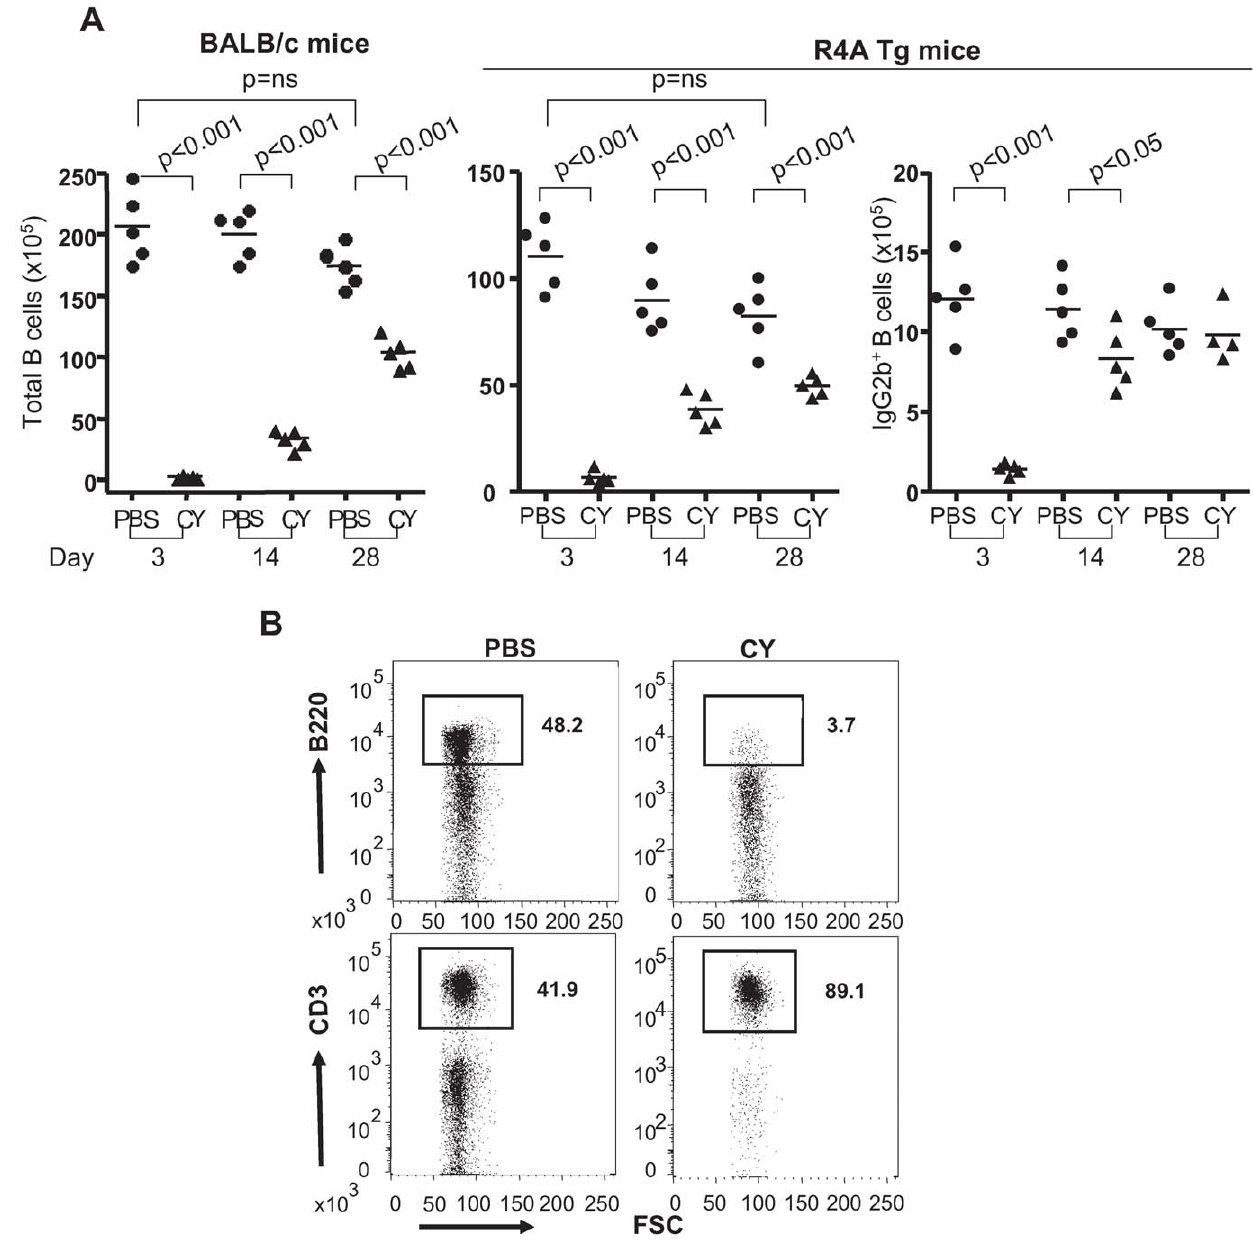
Figure 1. B cells following CY treatment. (A) B cell numbers following CY or PBS treatment. Flow cytometry was performed to identify B (B220 + ) cells and the Tg (IgG2b + ) B cells. The B cell numbers from individual mice is represented. A significant decrease in total B cell numbers in both the BALB/c WT mice as well as the BALB/c R4A Tg mice following CY treatment was observed at all time points analyzed, but was near normal by day 28. (B) Lymphocyte numbers following CY or PBS treatment. Flow cytometry was performed to identify B (B220 + ) cells and T (CD3 + ) cells. A representative dot plot is shown.